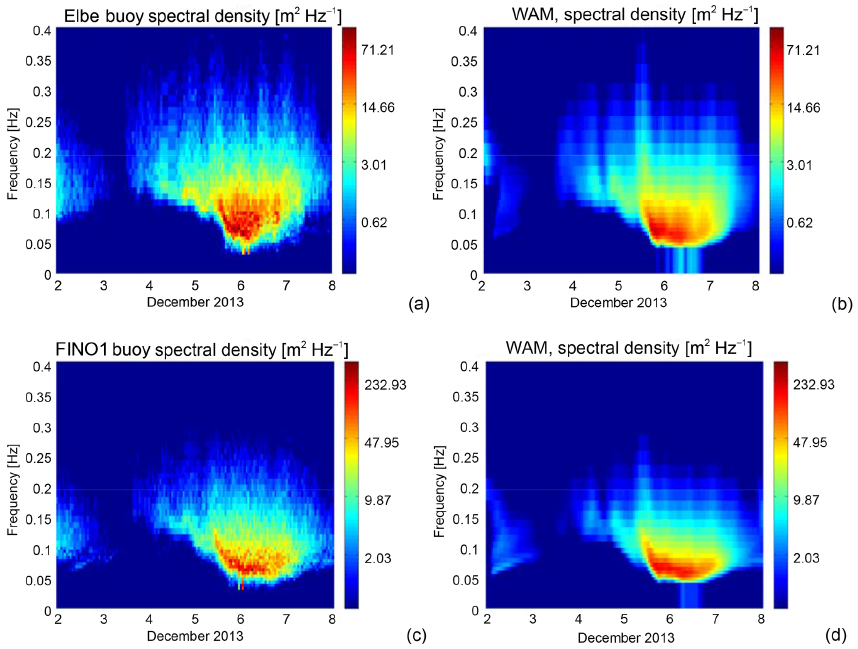
Figure 5. Comparison of measured (left) and computed (right) values of the spectral energy density at the Elbe buoy (top) and FINO1 buoy (bottom) (see Fig. 1 for